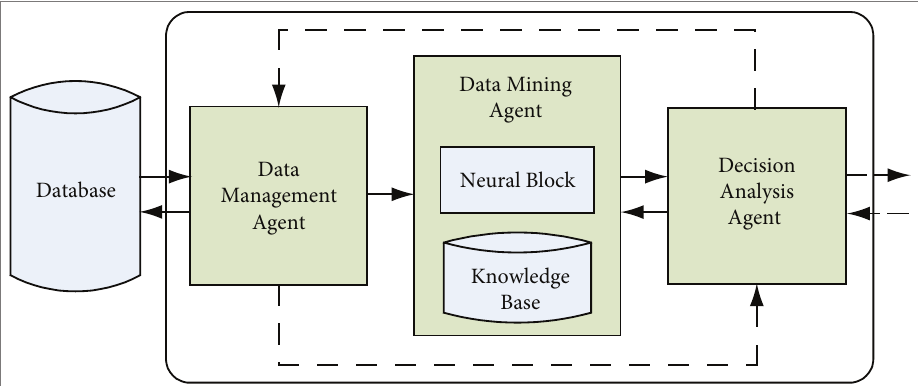
Fig. 1. Structure of the